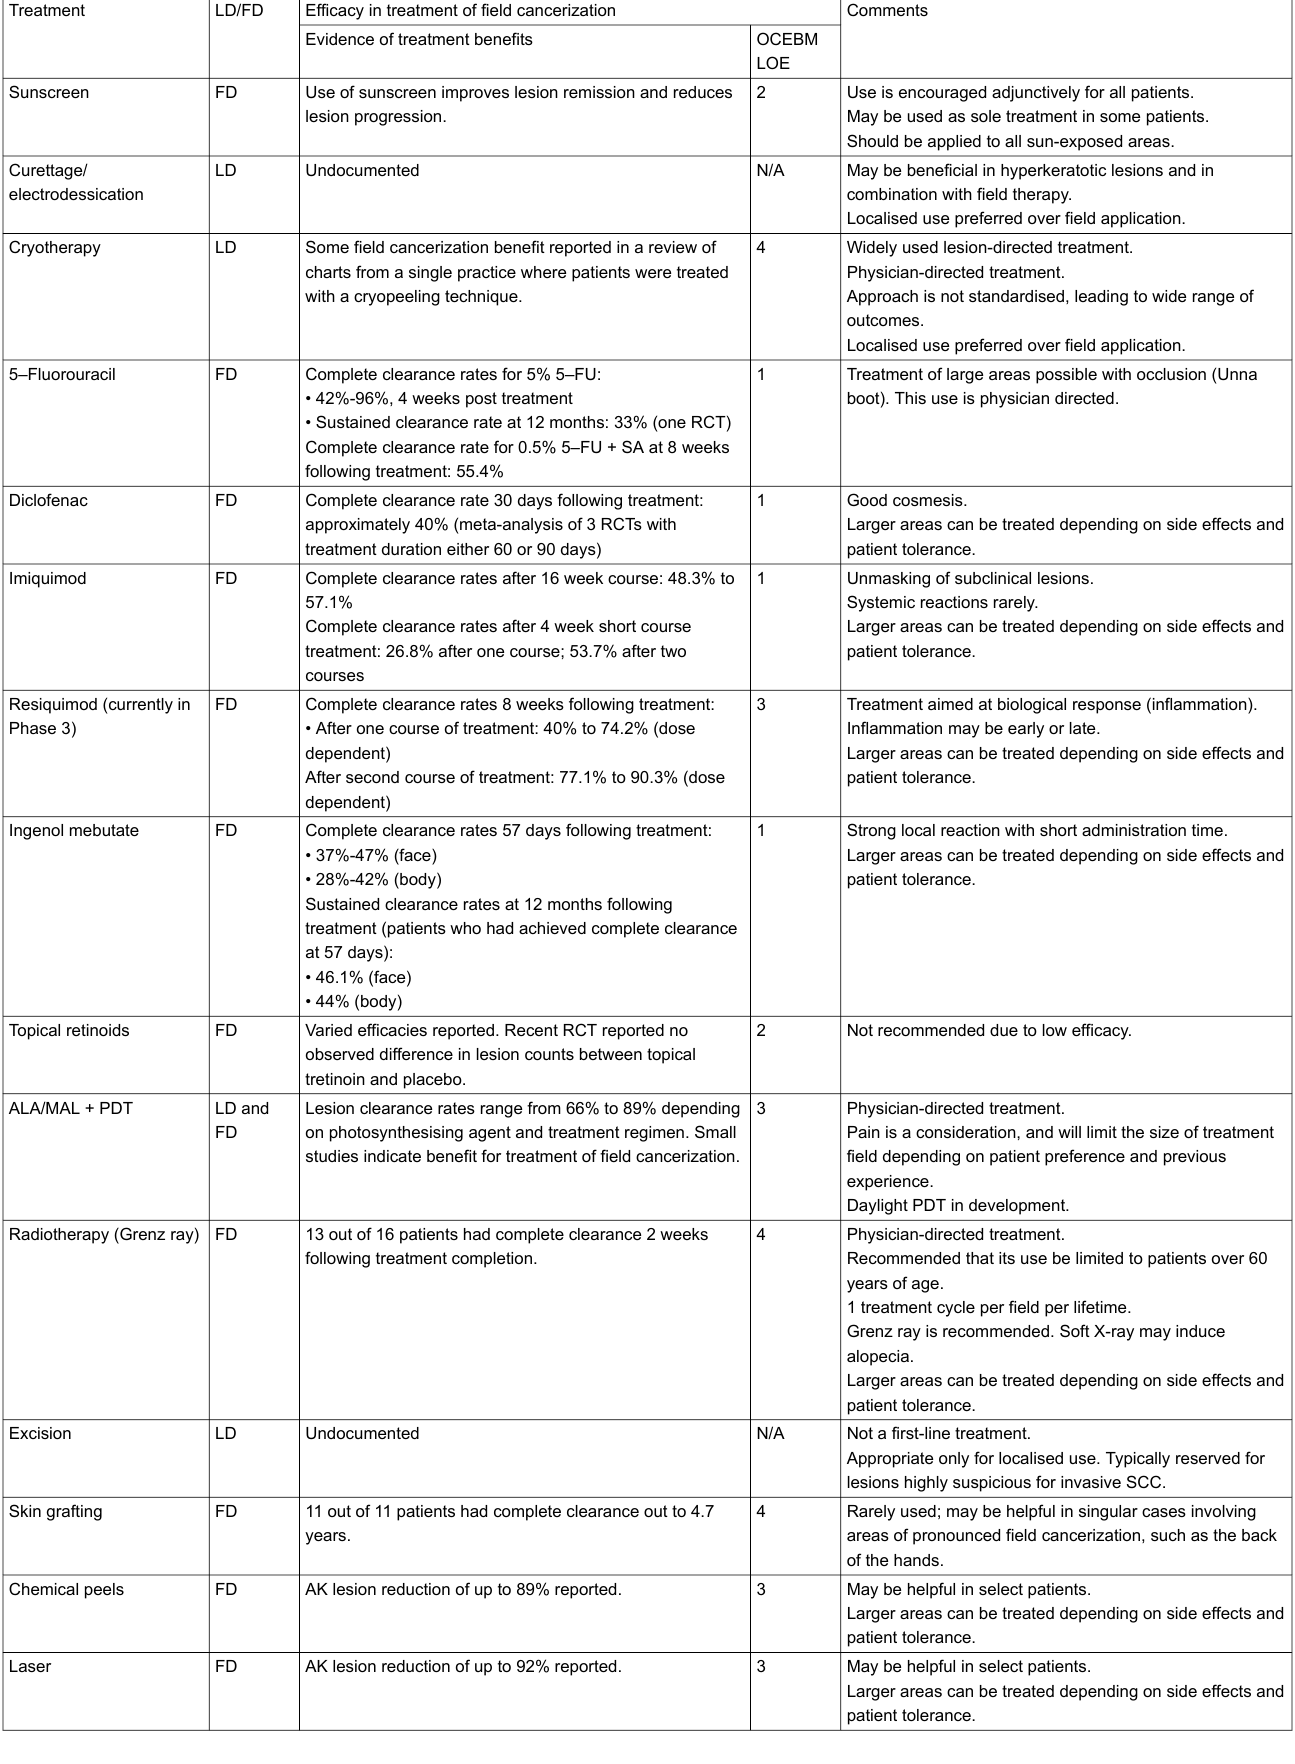
Table 3: Summary of treatments for actinic keratosis and efficacy in the treatment of field cancerization. Efficacy in treatment of field cancerizationTreatment